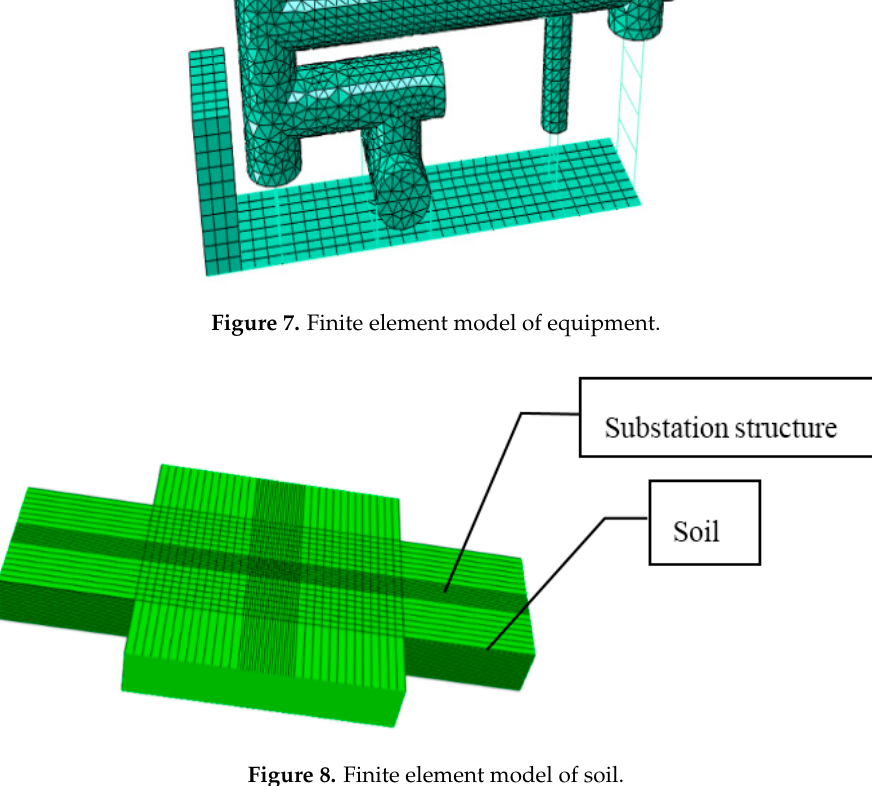
Figure 8. Finite element model of soil.